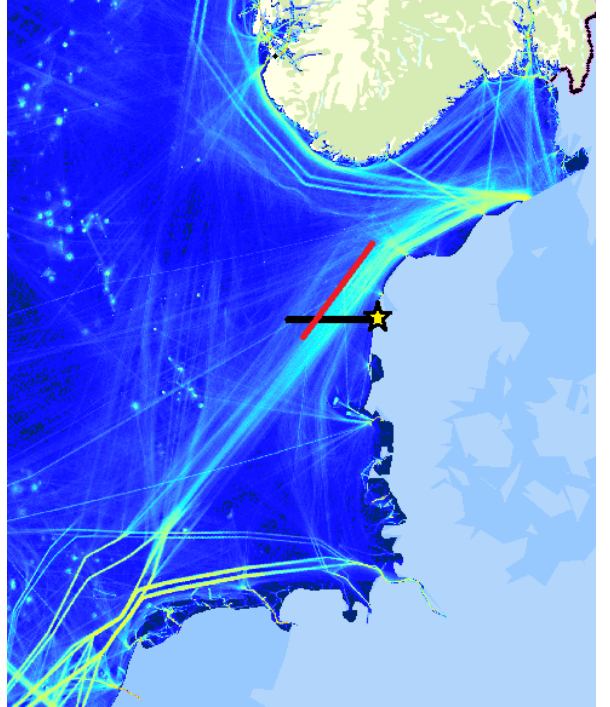
Figure 1. Map of total ship traffic in the western North Sea during the entire year 2012, based on the ship AIS data. The green and yel- low lines show the shipping lanes where ships have operated during the year. The yellow and black star is the location of the Høvsøre measurement site. We used the red line for defining air mass tra- jectories arriving over the shipping lane (Sect. 2.1) and the black line for calculating the number of ships that pass the site (Sect. 2.2). Apart from the star and the red and black lines this figure is provided by the Norwegian Coastal Administration.